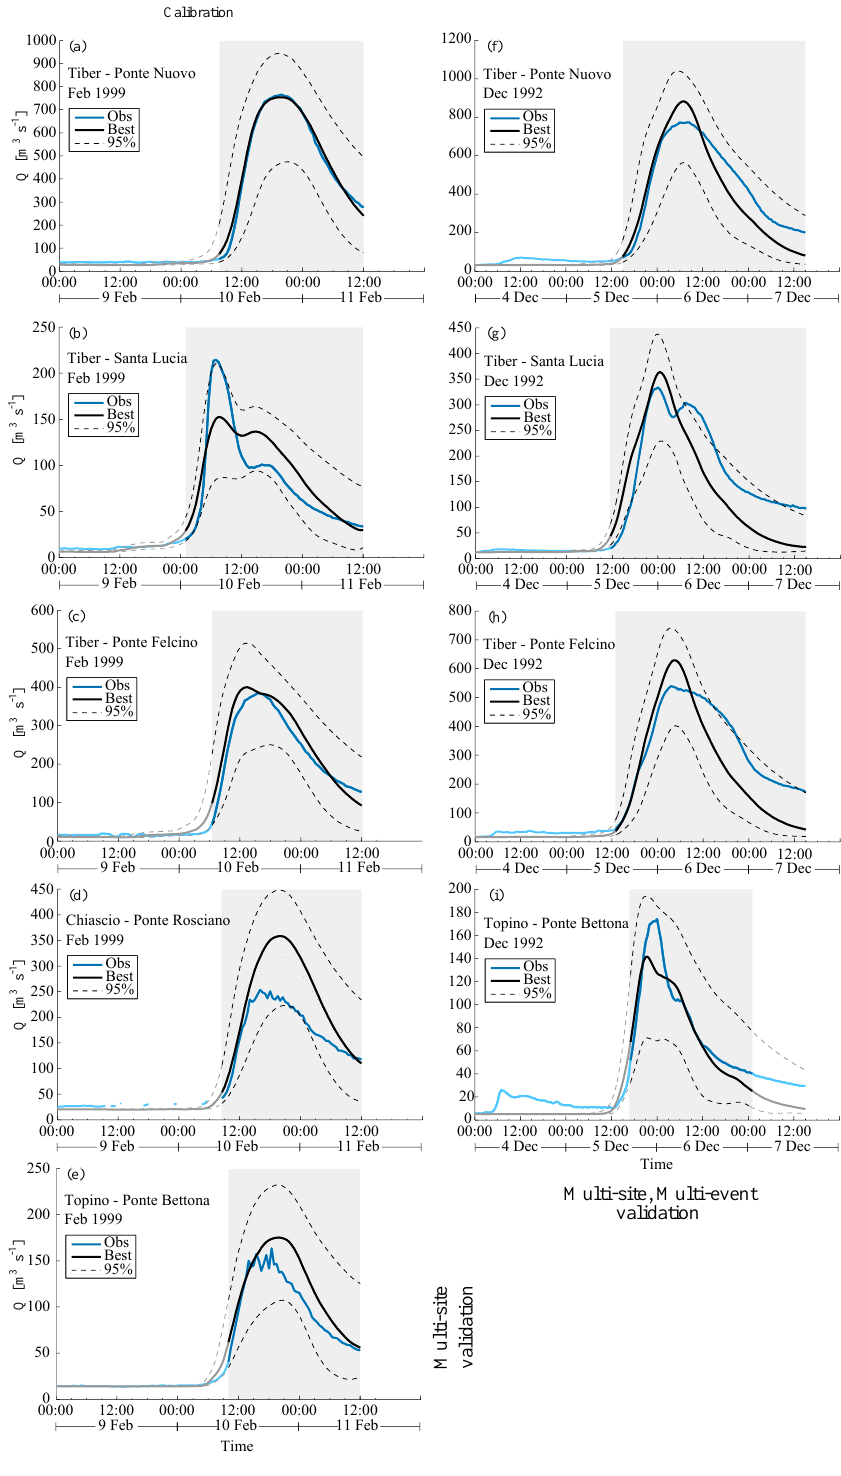
Figure 6. Comparison between 95% confidence band, water discharge simulated with the optimal parameter set and observed at all the gauging stations and events: subplots (a–e) 6–12 February 1999, and subplots (e–i) 4–7 December 1992. Shaded areas identify the period considered in the evaluation of P and R factors. Model parameters are estimated by using the discharge at Ponte Nuovo (PN) measured during the 1999 event (a)